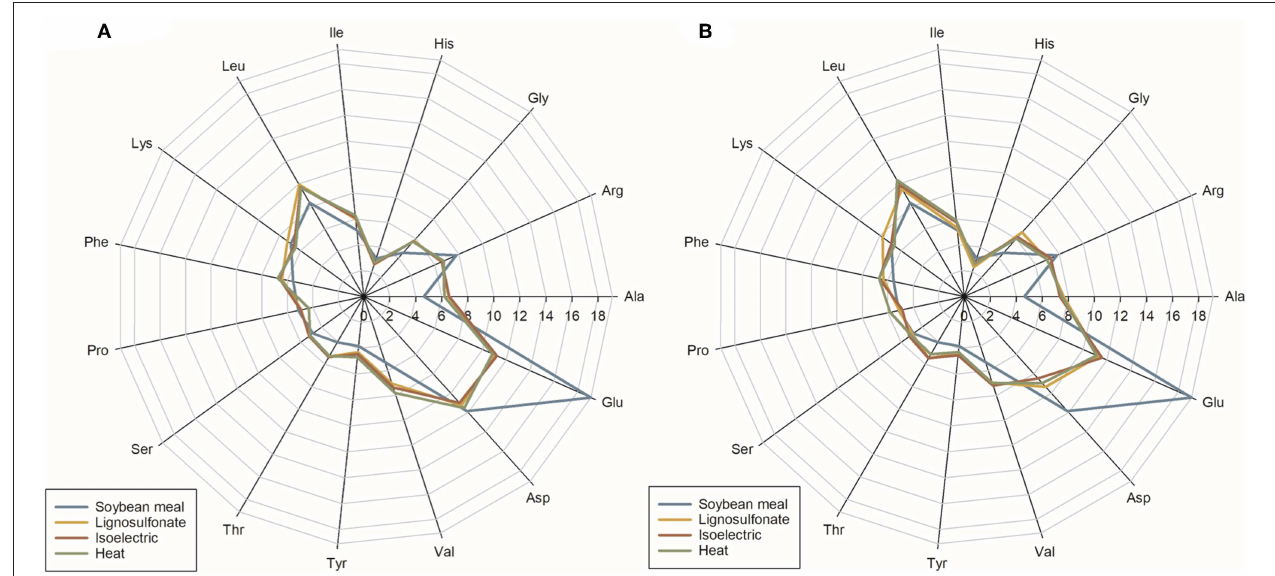
FIGURE 8 | Amino acid profile of the protein concentrates produced after precipitation of cleared juice from (A) red clover and (B) ryegrass. Values (%) are relative to total amino acid content. The protein was precipitated either by heat or isoelectric precipitation or addition of 4N eq. lignosulfonates. For comparison the amino acid profile of soy bean meal is included ( Lagos and Stein,